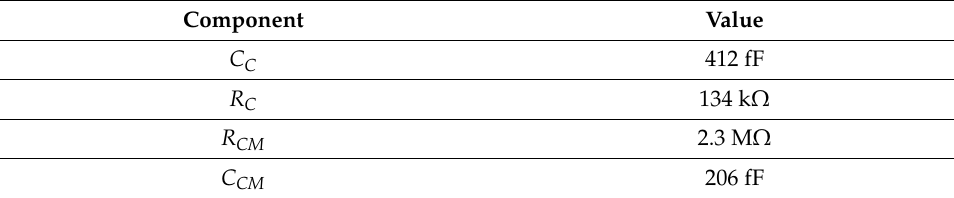
Table 2. Values of the passive components in the proposed CFIA.